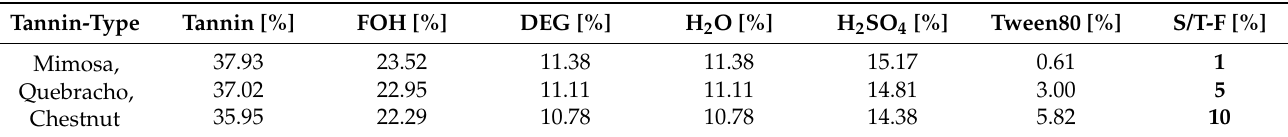
Table 3. Weight % of the different constituents of the foam formulations–3 different tannin-types for 3 different levels of surfactant concentration (1, 5,